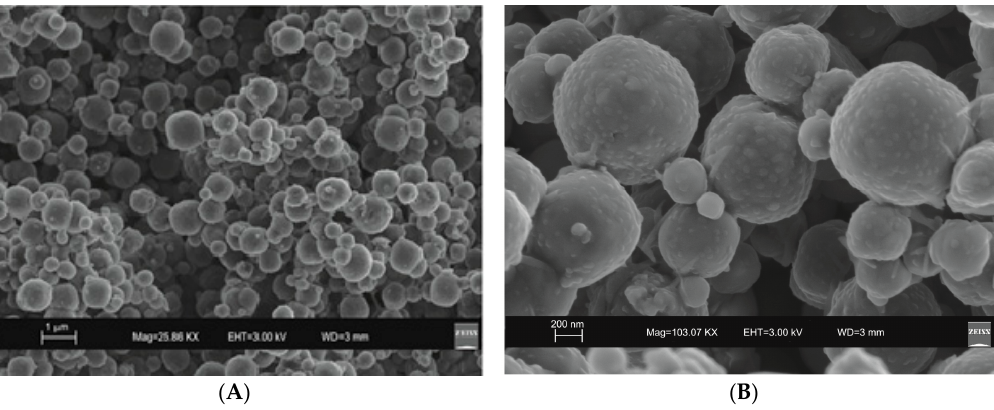
Figure 4. SEM images of LTA zeolite formed by a 4-day conventional hydrothermal incubation. ( A ) overview of zeolites formed; ( B ) zoom in on LTA crystals.